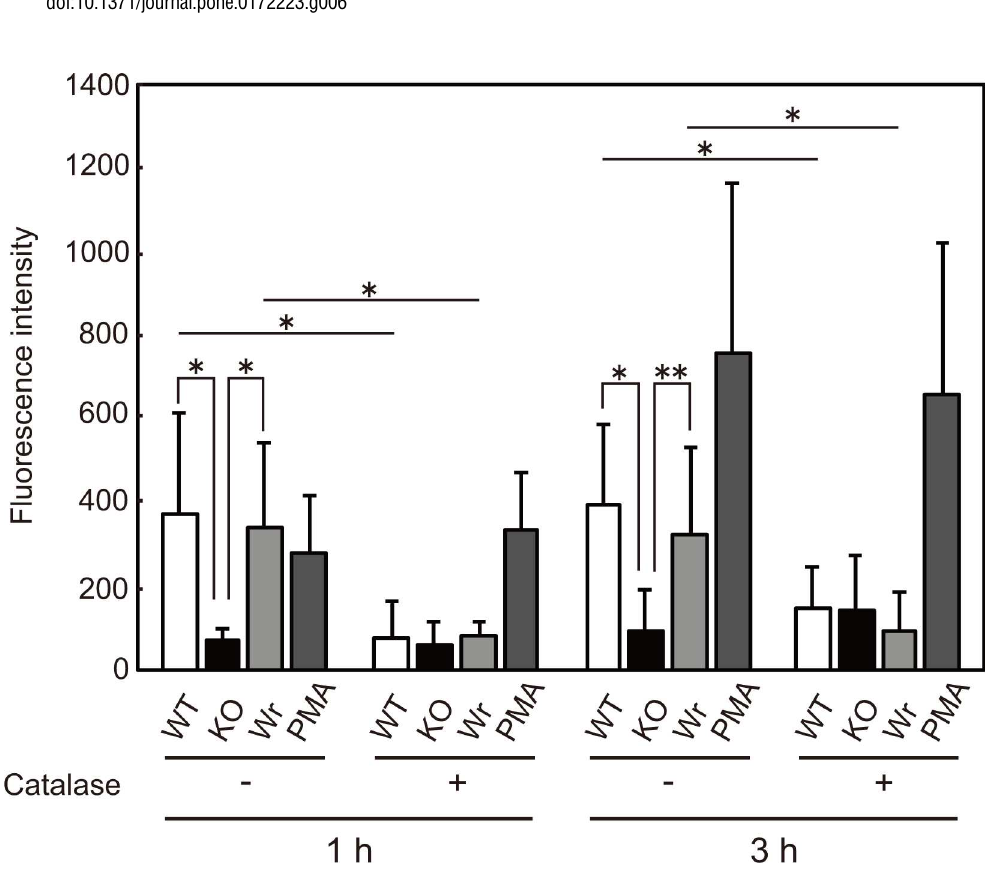
Fig 7. Extracellular DNA from neutrophils increased by streptococcal H 2 O 2 . Neutrophilswere infected with the S . sanguinis strains at an MOI of 10 with or without catalase(100 units/ml), and cultured for 1–3 h. Neutrophils treated with 200 nM of PMA served as a control. Cells were reacted with SYTOX Green and fluorescent intensity was determined.Data are presented as the mean ± SD of triplicate samplesfrom 3 independentexperiments. Statistically significantdifferences were evaluatedusing two-way ANOVA and Tukey’s multiple comparisontest. * p <